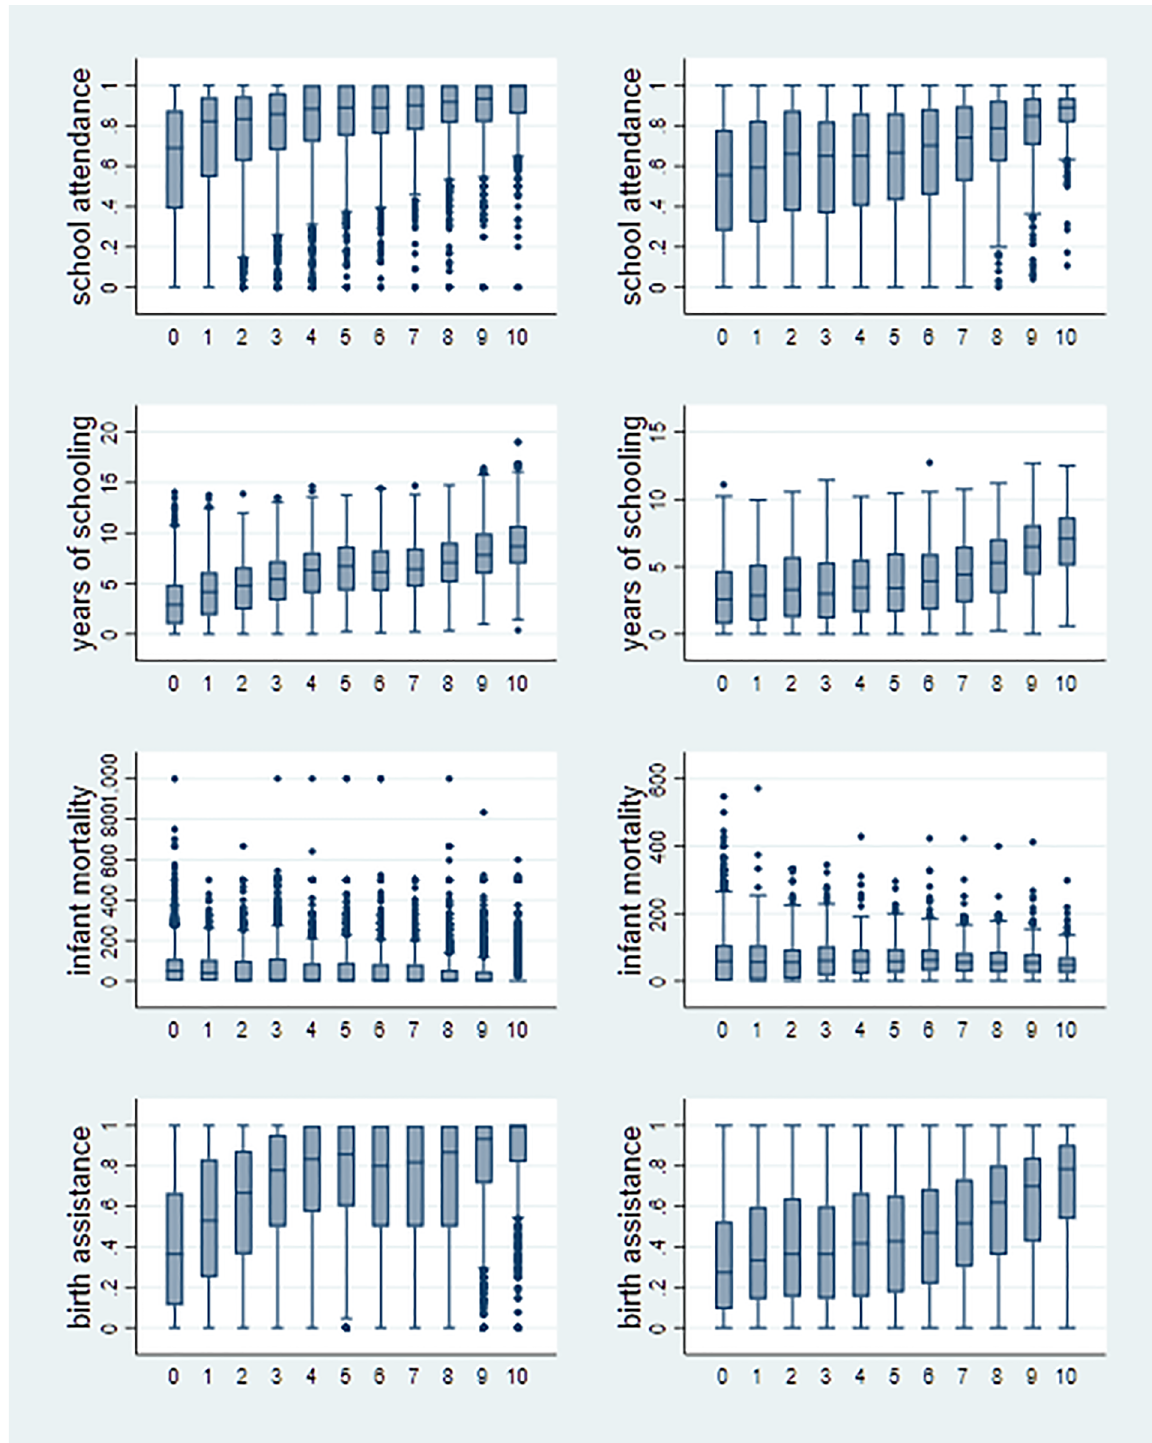
Fig 2. Distribution of development indicators over bins of nighttime lights. Graphs show box plots for four development indicators over 11 bins of nighttime light values. The development indicators are: primary school attendance, years of schooling, share of births assisted by professional health personnel, and infant mortality. Spatial units are circular zones of 2 km (5 km) radius around urban (rural) DHS clusters in the left column and PRIO-GRID cells in the right column. In each graph, the first bin contains all spatial units with zero average nighttime light; the remaining bins are based on the deciles of the nighttime lights distribution of the spatial units with above-zero nighttime lights. Boxes indicate the range from the 25th to the 75th percentile (interquartile range), with the median as a horizontal line; whiskers indicate the range of values within up to 1.5 times the interquartile range; and dots indicate values outside this range.